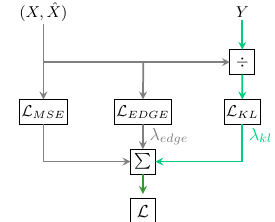
Figure 2. Proposed Cost